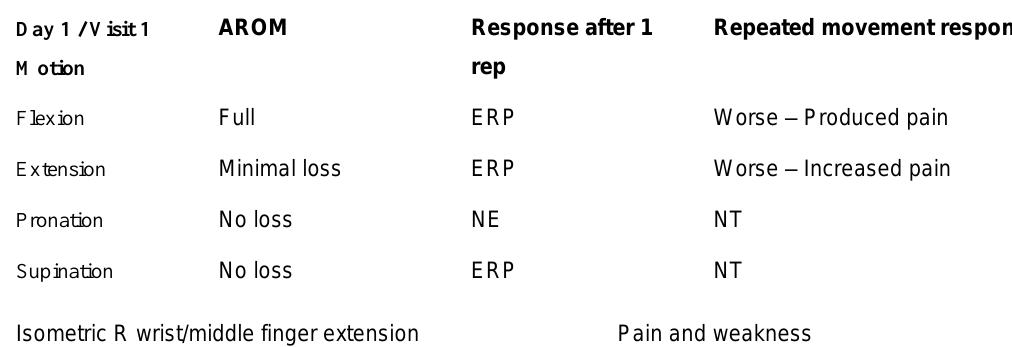
Table #7: Patient #3 - Right Lateral Elbow Pain Mechanical Assessment: Active Range of Motion and Repeated Movements of the Right